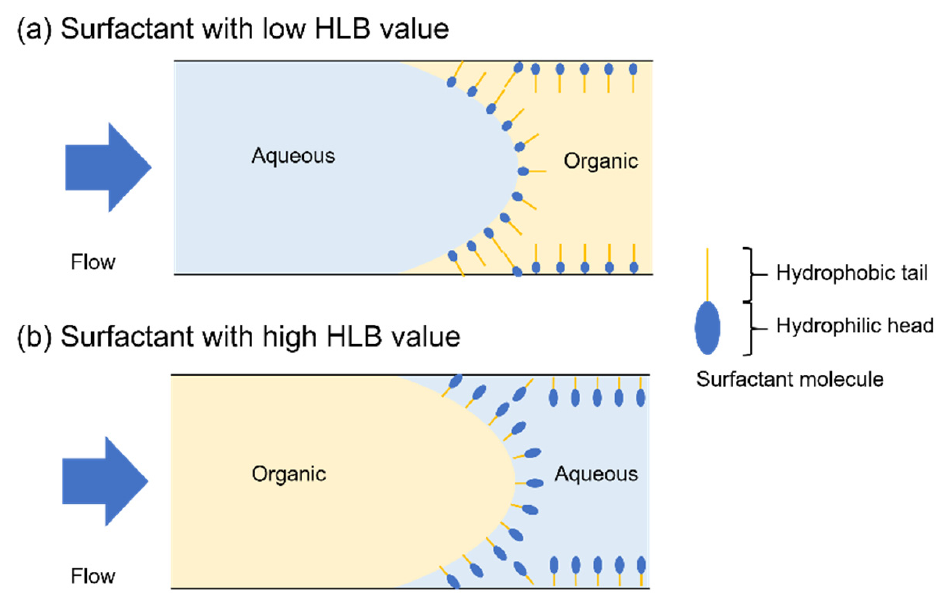
Figure 6. Interface of the aqueous and organic phases at the droplet generation area when using the surfactant with ( a ) a low HLB value and ( b ) a high HLB value. Table 3. Combinations of continuous-phase and dispersed-phase solutions used in this work. Dispersed Phase (Droplets)